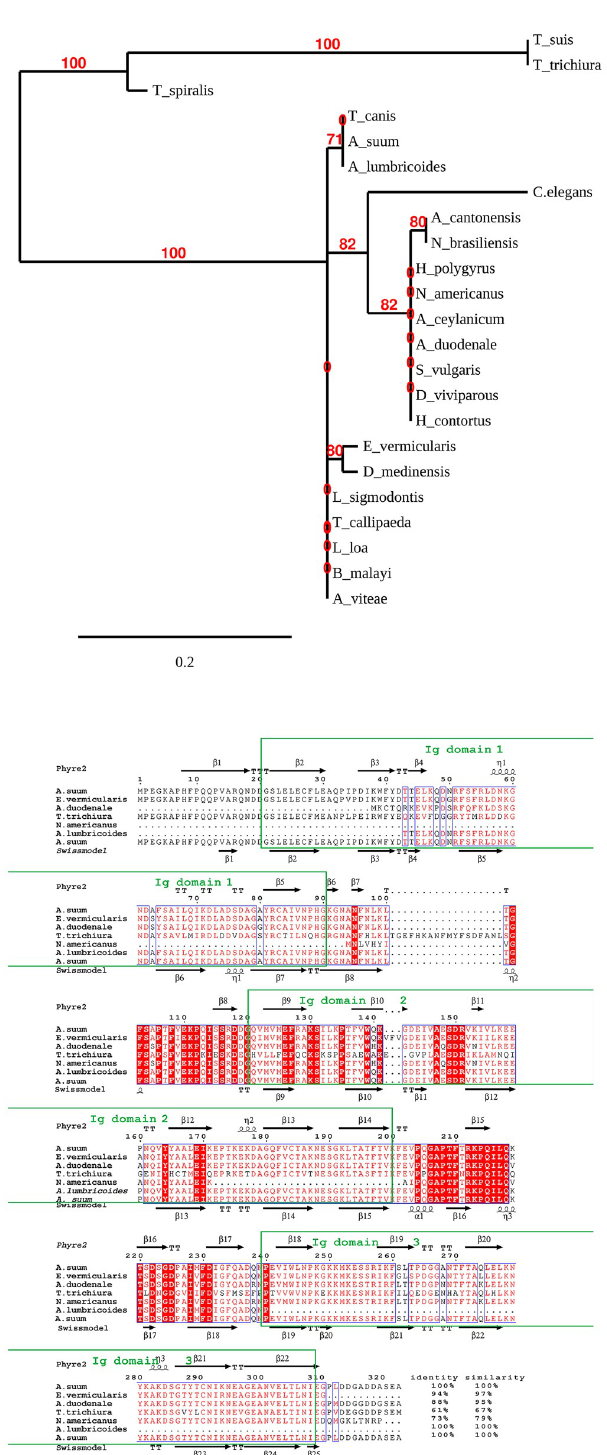
Fig 3. Sequence alignment of As37 with its homologs in other nematodes. (Top) Phylogenetic tree of As37 and its homologs in other nematodes, with branch support values in red. The sequences include As37 from A . suum (GenBank accession# BAC06575.1), A . lumbricoides (ALC00246), Toxocara canis (KHN88700.1), Caenorhabditis elegans (NP_001024421.1), Angiostrongylus cantonensis (KAE9417345.1), Nippostrongylus brasiliensis (VDL70373.1), Heligmosomoides polygyrus (VDP04139.1), Necator americanus (XP_013297867.1), Ancylostoma ceylanicum (EPB67396.1), A . duodenale (KIH68744.1), Strongylus vulgaris (VDM74829.1), Dictyocaulus viviparous (KJH47142.1),